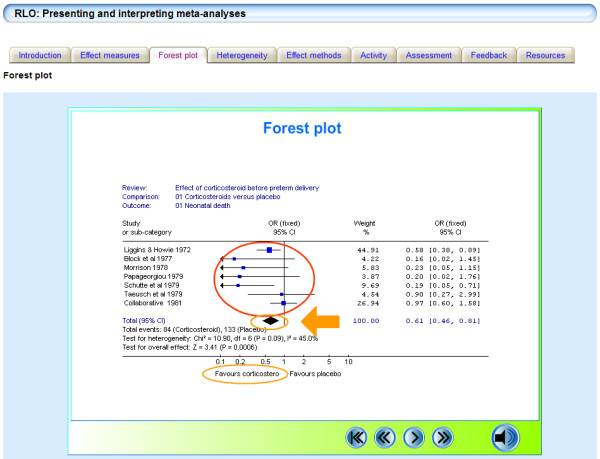
Screen shot from the Presenting and interpreting Meta-analysis RLO. This RLO covers effect measures, forest plots, heterogeneity and effect methods.